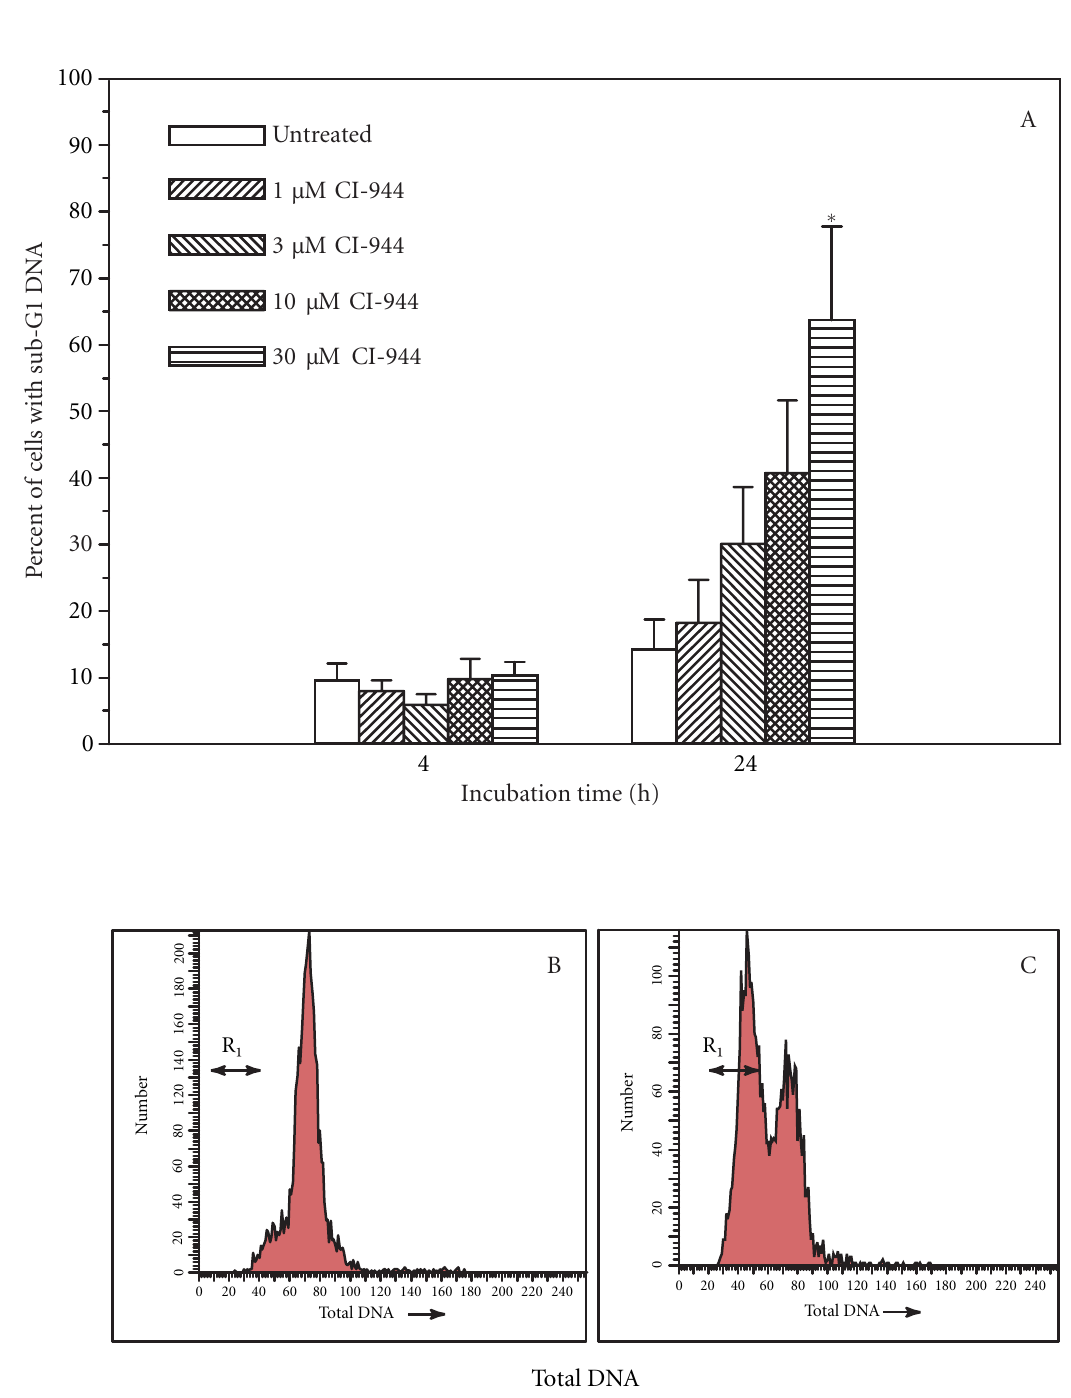
Figure 5: Sub-G1 DNA content in rat peripheral blood lymphocytes exposed to CI-994 for 4 or 24hours. (A) Sub-G1 DNA content quantitated by flow cytometry and Hoechst 33342 stain. Mitogen (concanavalin A, 0.63 µ g/ml) was added to all lymphocyte cultures at time zero. Data represent the mean ± SE of at least 4 individual experiments. ∗ Significantly different from control using Kruskal-Wallis one way ANOVA on ranked data and Dunn’s post hoc test ( p < 0 . 05 ). Representative DNA histograms of (B) untreated rat peripheral blood lymphocytes and (C) lymphocytes treated with 30 µ M CI-994 for 24hours. R 1 = gated sub-G1 DNA